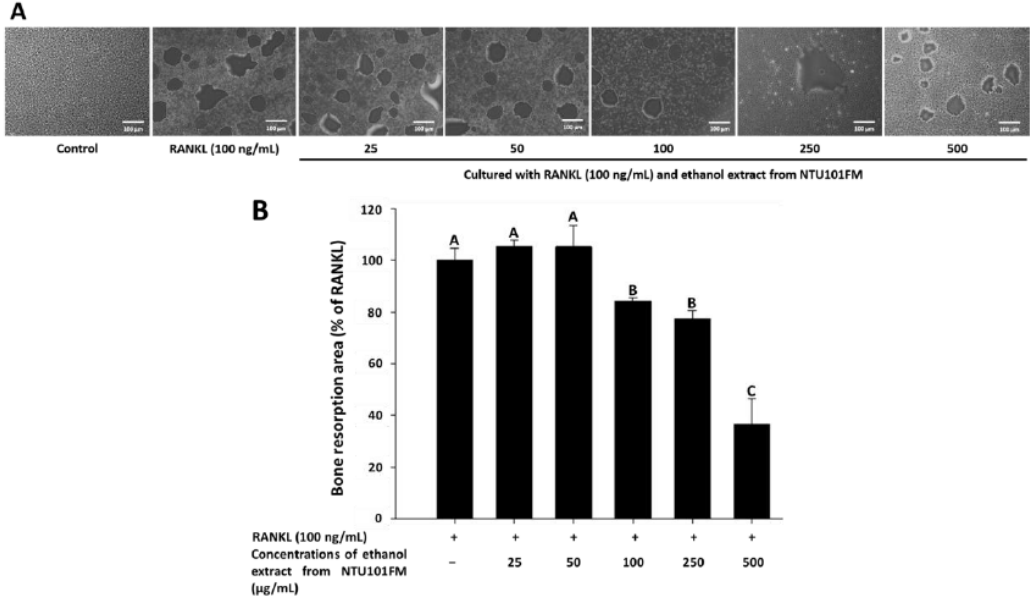
Figure 4. Effect of NTU101FM ethanol extract on RANKL-induced bone resorption: ( A ) photograph; and ( B ) the area in osteoclast. The RAW 264.7 cells were cultured with the indicated dose of NTU101FM ethanol extract (25 to 500 µ g/mL) in the presence of RANKL (100 ng/mL) for four days. The data are presented as means ± SD ( n = 3). Values with different uppercase letters were significant by Duncan’s multiple range tests ( p < 0.05). NTU101FM, NTU 101-fermented skim milk; RANKL, receptor activator of nuclear factor kappa- β